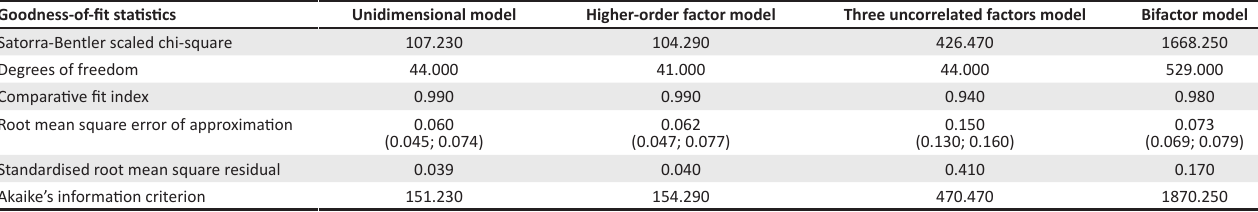
TABLE 1: Goodness-of-fit statistics for the competing measurement models (RSLQ, n = 405). Goodness-of-fit statistics